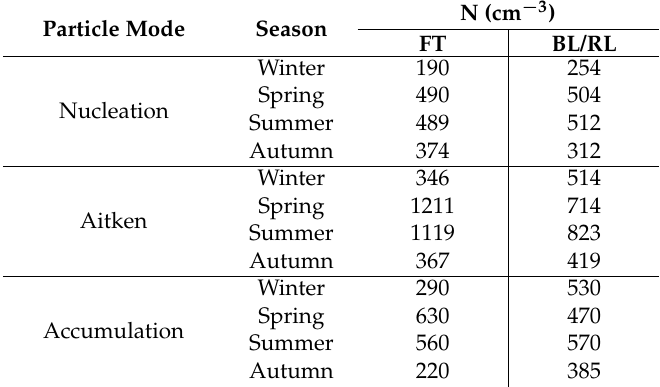
Table 2. The mean concentration of the Nucleation, Aitken, and Accumulation mode particles for the four seasons. Particle